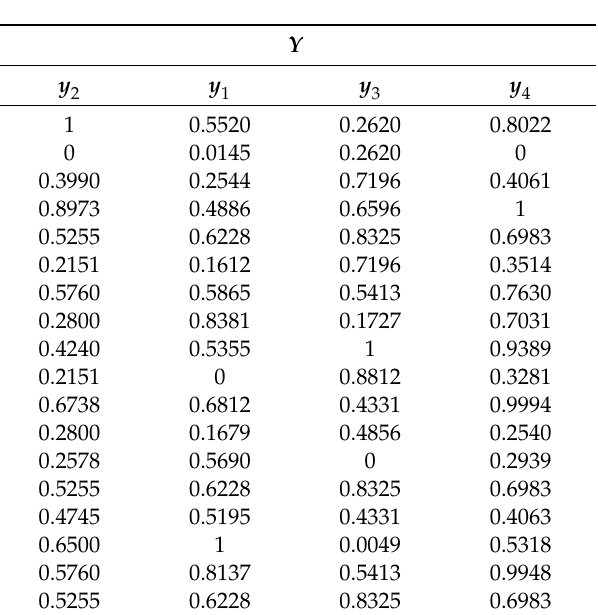
Table 4. Normalized values of matrix Y